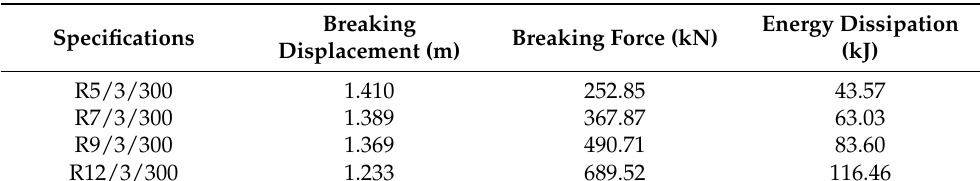
Table 5. Equivalence breaking force and breaking displacement of ring nets with different specifica- tions under a static punching condition.